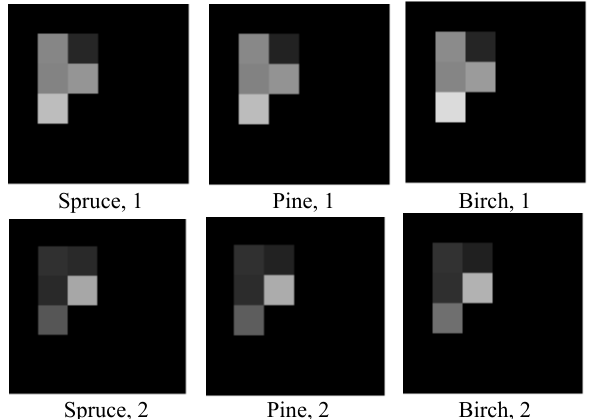
Figure 5. Examples of feature images. Number 1 corresponds to an illuminated case and number 2 corresponds to a shadowed case.